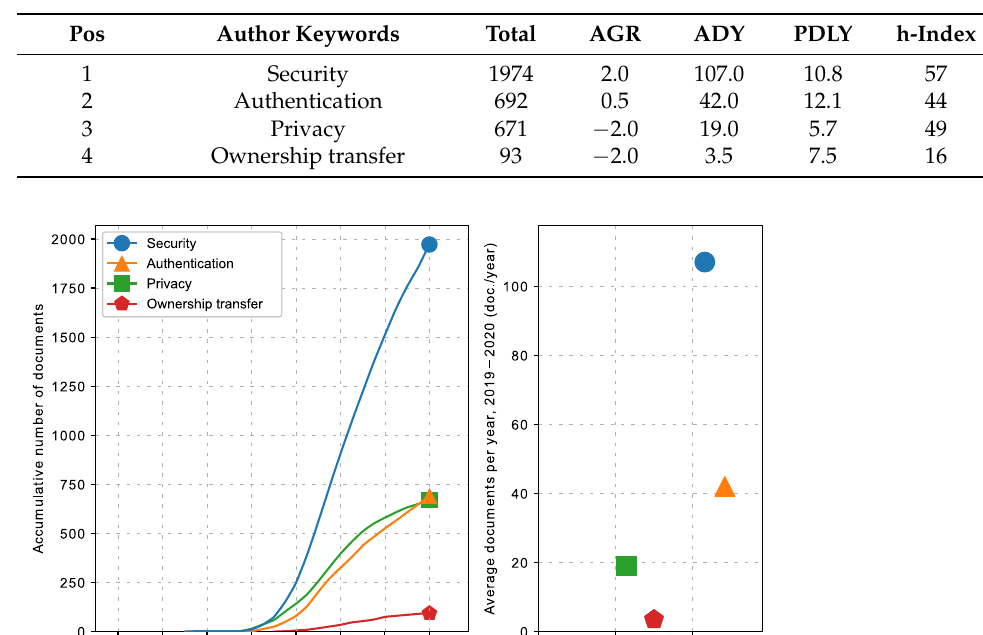
Table 3. Top author keywords for security- and privacy-related topics.